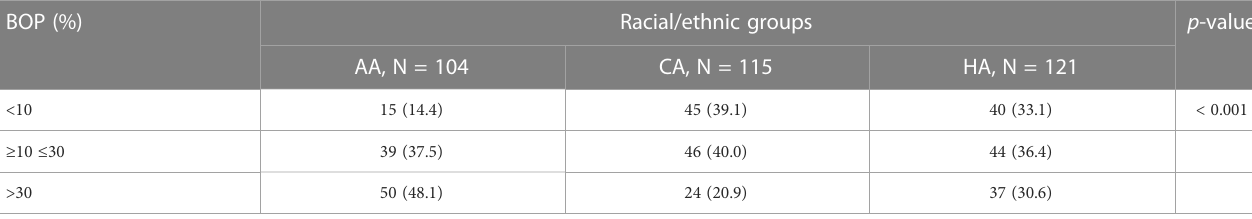
a BOP: Bleeding on probing, detailed BOP data is listed in Supplemental Table 1. b PI: Modi fi ed O ’ Leary plaque index, detailed BOP data is listed in Supplemental Table 1. c Tooth number is based on 32. d BMI, Body mass